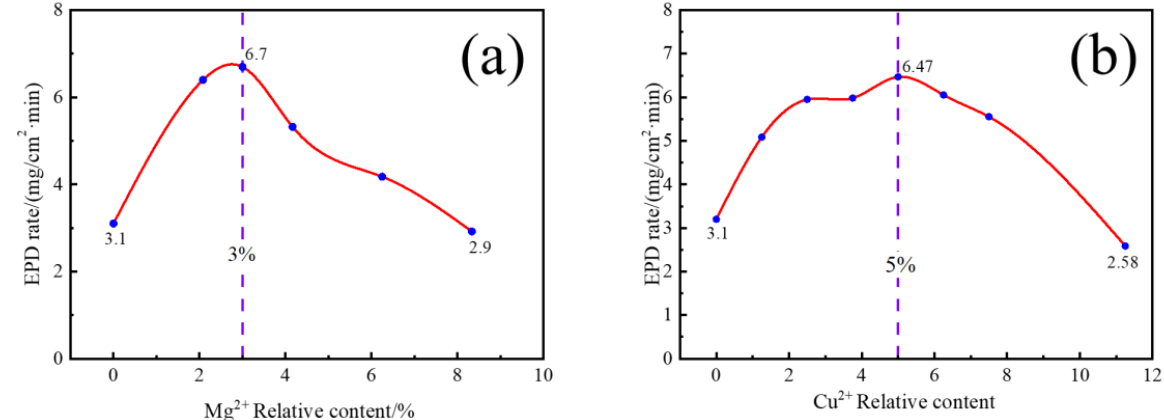
Figure 1. EPD rate of nano-TbF 3 with different relative content of Mg 2+ ( a ) and Cu 2+ ( b ). The EPD behavior with different time was studied by adding the best relative content of Mg 2+ and Cu 2+ . Figure 2 shows the EPD TbF 3 amount (a) and EPD rate (b) of